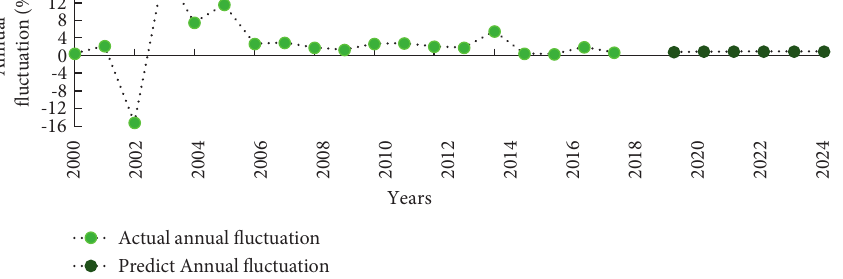
Figure 7: The fluctuation rate of total grain yield in Henan